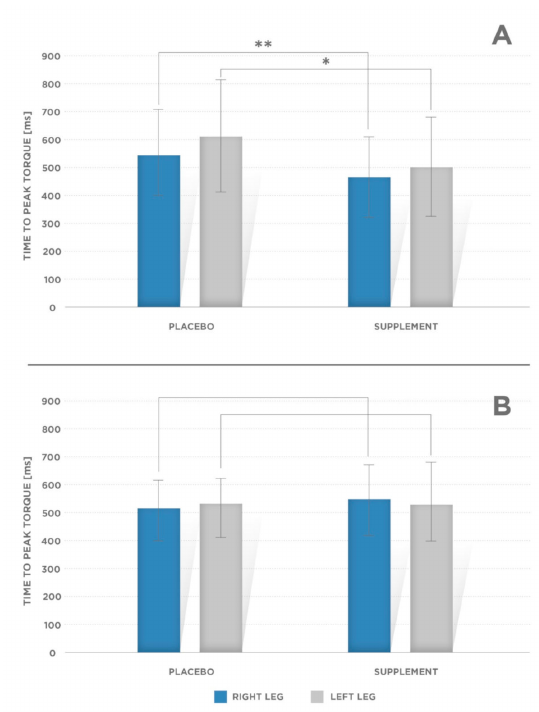
Figure 2. Mean values of time to peak torque (TTP) at 60 ◦ / s for ( A ) the right and left knee flexors. Significant di ff erence was observed for the right leg (** p = 0.002) and left leg (* p = 0.002) and ( B ) for the right and left knee extensors. Significant di ff erence for extensors was not observed for the right ( p = 0.818) and left leg ( p = 0.422). Error bars indicate standard deviation